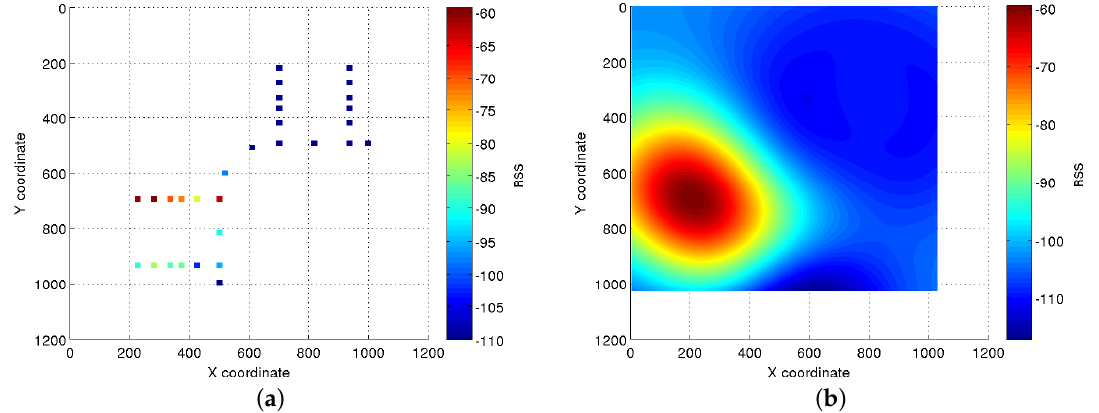
Figure 2. Discrete information and continuous reference surface estimated for an AP. ( a ) Discrete information matrix; ( b ) estimated RSS reference